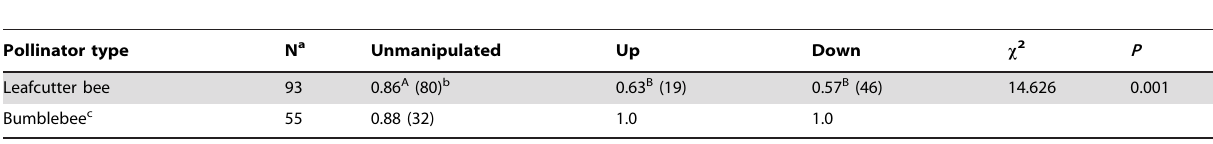
Table 2. Effects of changes in floral orientation on the percentage of upward movements to total vertical movements on inflorescences by leafcutter bees and bumble